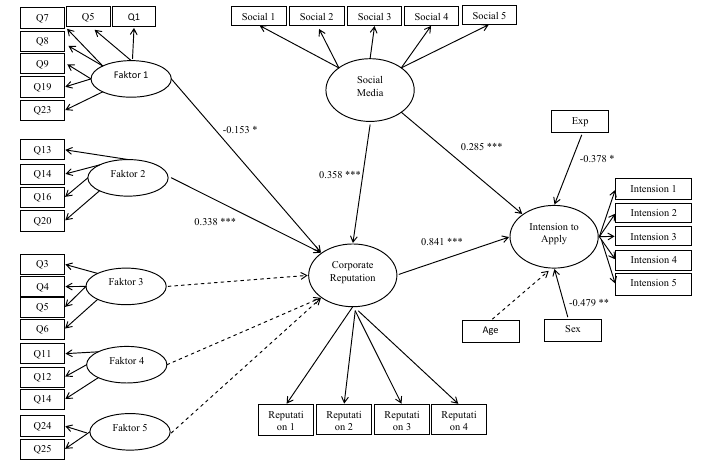
Fig. 2 – Overall results for the data set of students of IT. Source: own